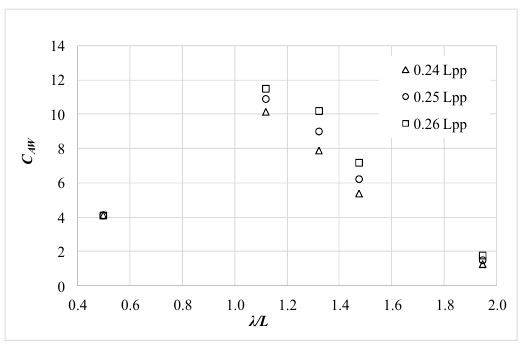
Figure 7. Influence of pitch gyration radius on added resistance coefficient in regular waves.